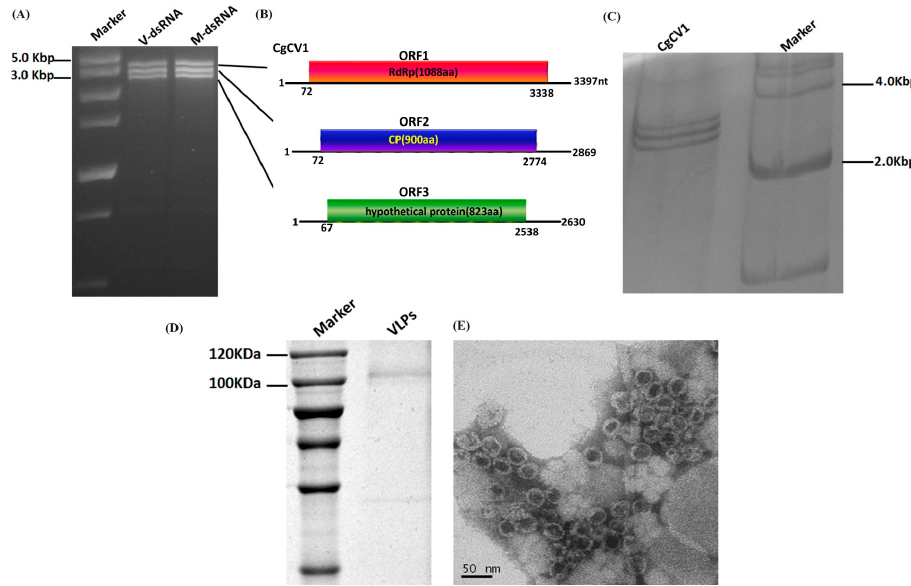
Figure 1. Agarose gel electrophoresis of double ‐ stranded RNA (dsRNA) isolated from Colletotrichum gloeosporioides strain HZ ‐ 1, the genome organization of Colletotrichum gloeosprioides chrysovirus 1 (CgCV1), and analysis of isometric virus ‐ like particles (VLPs) of CgCV1. ( A ) dsRNA segments were electrophoresed on a 2% agarose gel stained with ethidium bromide, with the size estimated using a DNA size marker. V ‐ dsRNA and M ‐ dsRNA indicate the dsRNAs extracted from the VLPs and mycelium mass, respectively; ( B ) Diagrammatic representation of the putative genome organization of CgCV1, consisting of three dsRNAs. Each dsRNA segment potentially encodes the RNA ‐ dependent RNA polymerase (RdRp) (dsRNA1), the coat protein (CP) (dsRNA2), and the putative protease (dsRNA3), which are represented by rectangular boxes with different colors. The initiation and termination codons of the respective open reading frames (ORFs) are indicated by the numbers under the solid lines; ( C ) Silver nitrate ‐ stained 12% acrylamide gel showing dsRNAs from CgCV1; ( D ) 10% sodium dodecyl sulphate ‐ polyacrylamide gel electrophoresis (SDS ‐ PAGE) analysis of the protein, which was indicative of a capsid protein of CgCV1 extracted from the virus ‐ infected fungal strain HZ ‐ 1 (lane 2). The molecular weight of the protein band was estimated by the protein marker in lane 1. ( E ) Isometric VLPs were observed by transmission electron microscopy (TEM) after being negatively stained with 2% uranyl acetate. Scale bar = 50 nm.